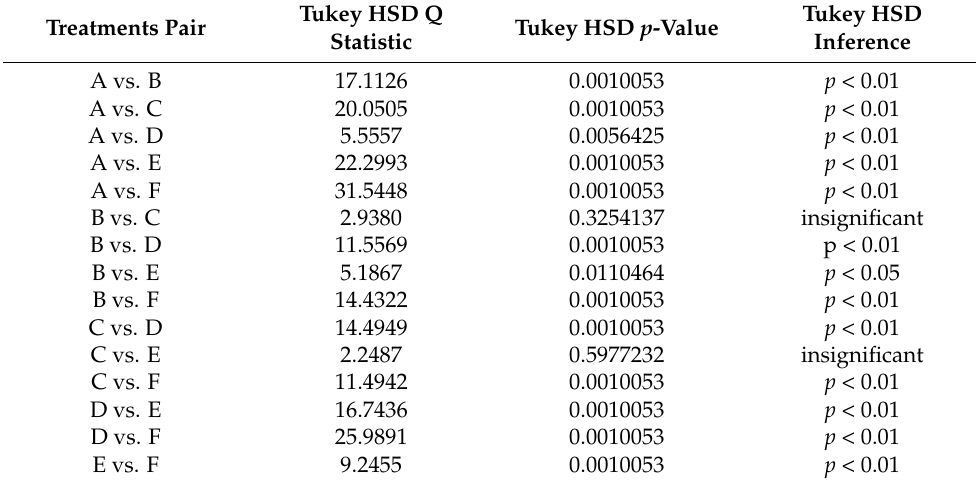
Table 5. Tukey HSD test